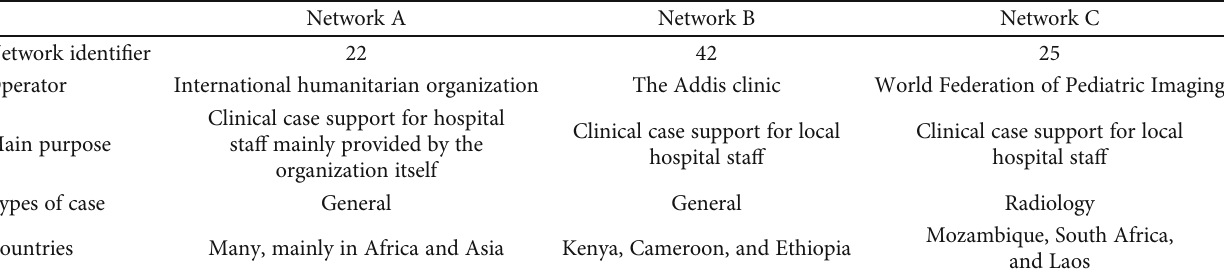
Table 2: Characteristics of the three Collegium networks